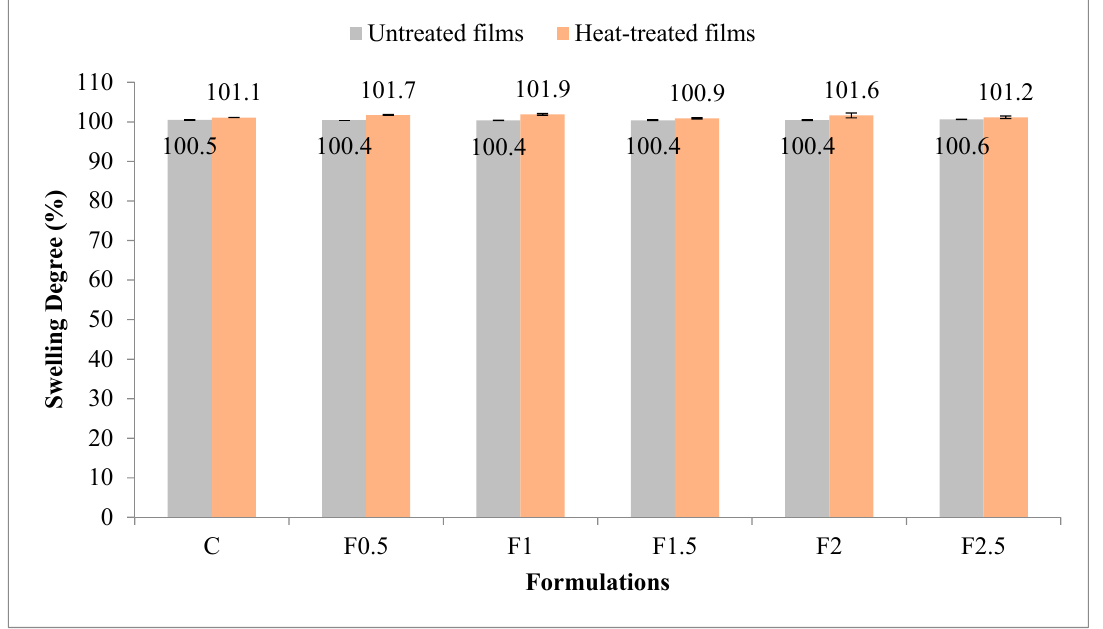
Figure 4. Variation in swelling degree with heat treatment and formulation. C-control film; F0.5-film with 0.5% tarragon essential oil; F1-film with 1% tarragon essential oil; F1.5-film with 1.5% tarragon essential oil; F2-film with 2% tarragon essential oil; F2.5-film with 2.5% tarragon essential oil. Values are expressed as mean ± standard deviation of three replicates.